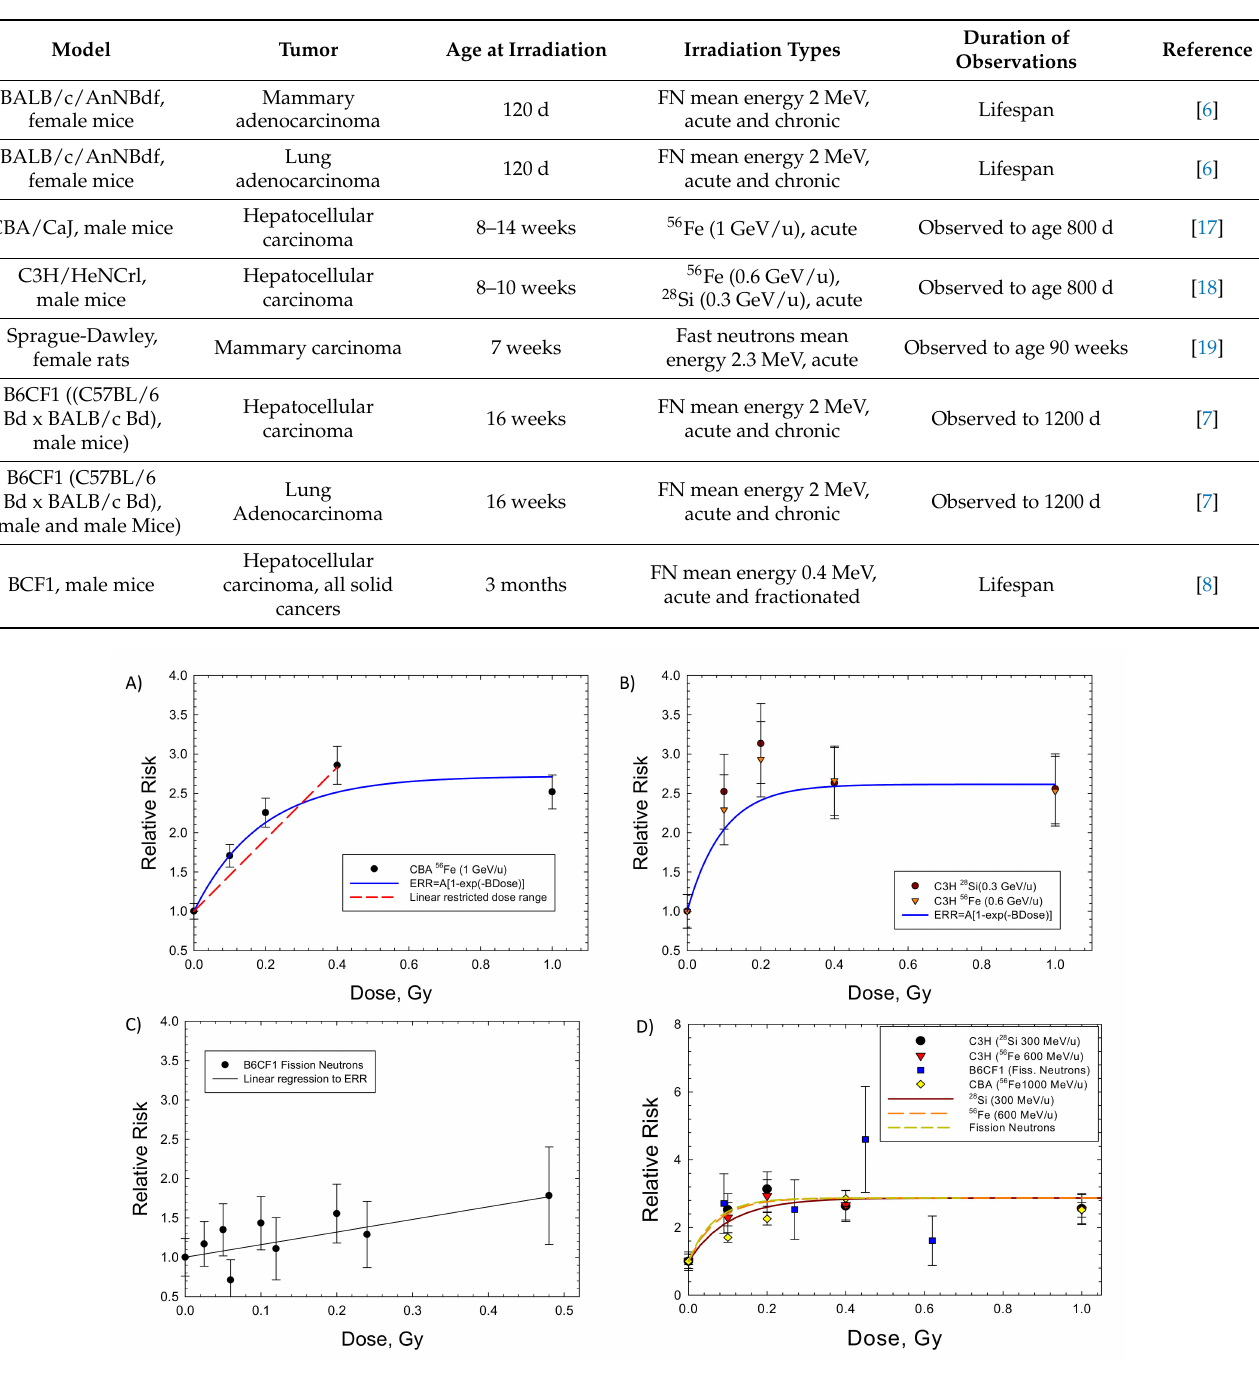
Figure 1. Dose responses for the relative risk of hepatocellular carcinomas in several strains of male mice exposed to heavy ions (HIs) or fission neutrons (FN). The saturable ERR model described in the text is compared to the experimental data. ( A ) CBA exposed to HIs [17], ( B ) C3H exposed to HIs [18], ( C ) B6CF1 exposed to FN [7]. ( D ) Model fits to several strains of mice showing similarity of HI and FN responses from